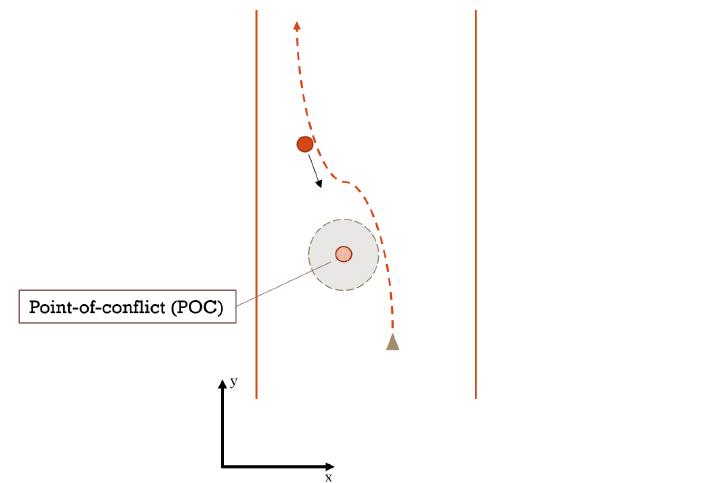
Figure 4. Obstacle avoidance with